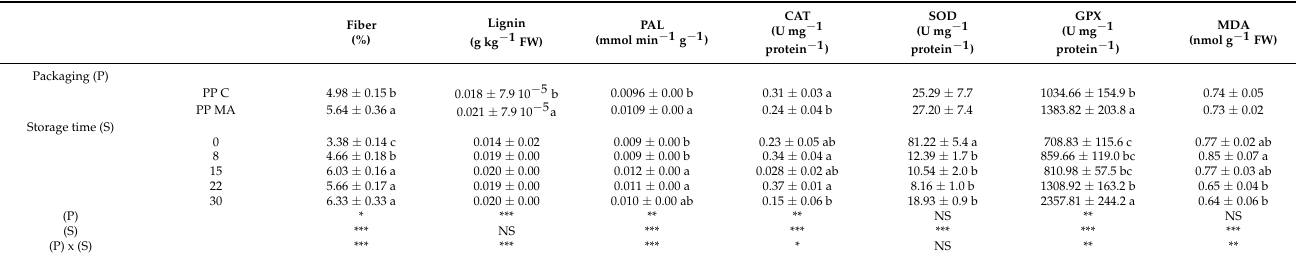
Table 3. Effects of “packaging” and “storage time” on fiber (%), lignin content (g kg − 1 FW), phenylalanine ammonia- lyase (PAL) activity (mmol min − 1 g − 1 ), catalase (CAT), glutathione peroxidase (GPX), and superoxidedismutase (SOD) activity (U mg − 1 protein − 1 ), and malondialdehyde content (MDA) (nmol g − 1 FW) on green asparagus spears ( Asparagus officinalis L. ‘Vegalim’). Two packaging materials were considered—PP C (polypropylene micro-perforated bags) and PP MA (polypropylene macro-perforated